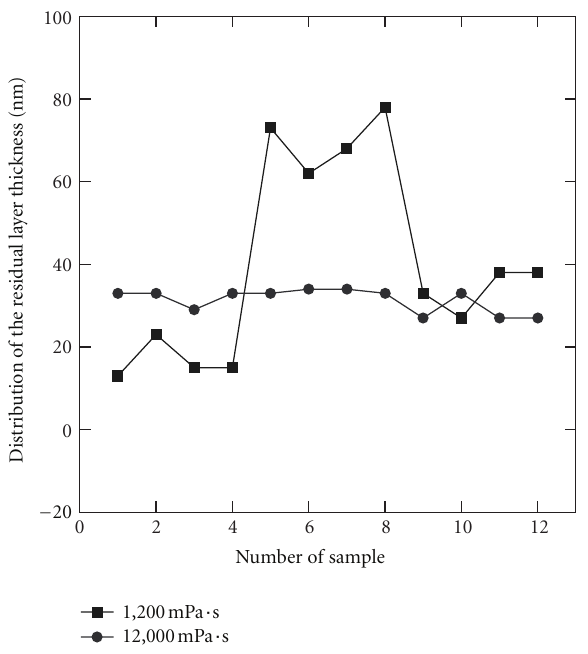
Figure 8: Comparison of residual layer thicknesses between high- and low-viscosity resins. With high-viscosity resin, residual layer thickness uniformity was within 30 nm ± 10%; with low-viscosity resin, residual layer thickness uniformity was greater than 50 nm.